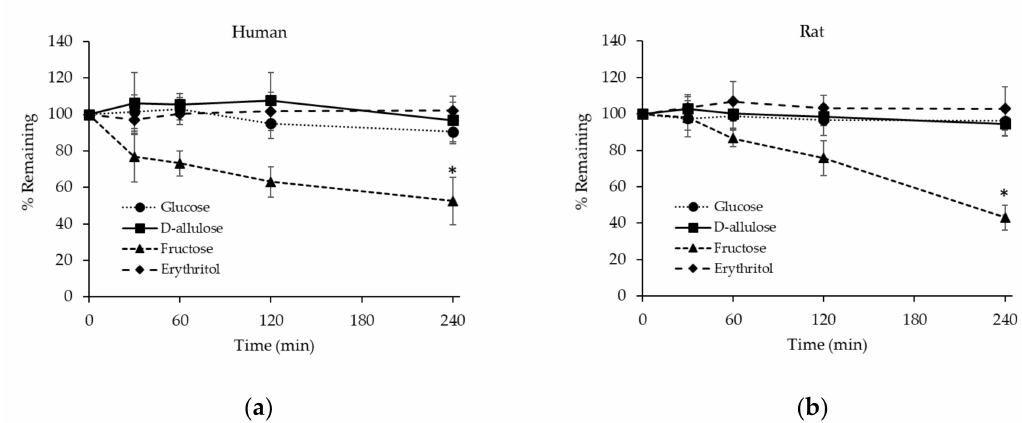
Figure 4. Percentages of test substances remaining as a function of time after incubation in human ( a ) or rat ( b ) hepatocytes. Results are presented as means and error bars represent standard deviations. ( n = 5 at each time point). * Significantly di ff erent from the other groups ( p < 0.001).